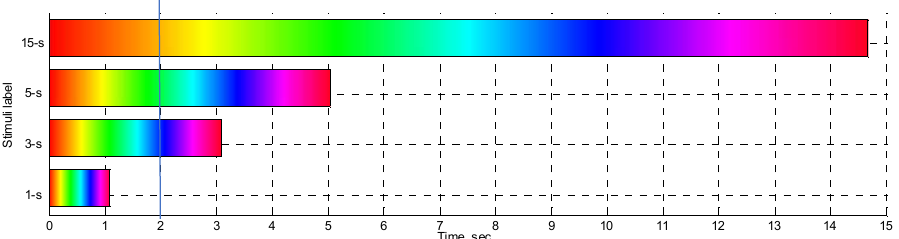
Figure 1. Time course of the color presentation for “1-s”, “3-s”, “5-s”, and “15-s” stimuli. Visual stimulation was presented using an overhead projector (Epson Home Cinema 8350) on a white screen located approximately two meters in front of the participants’ eyes. The image on the screen was approximately 2.2 m wide and 1.25 m high, effectively covering most of the subjects’ visual field with horizontal and vertical viewing angles of approximately 57 and 34 degrees, respectively.